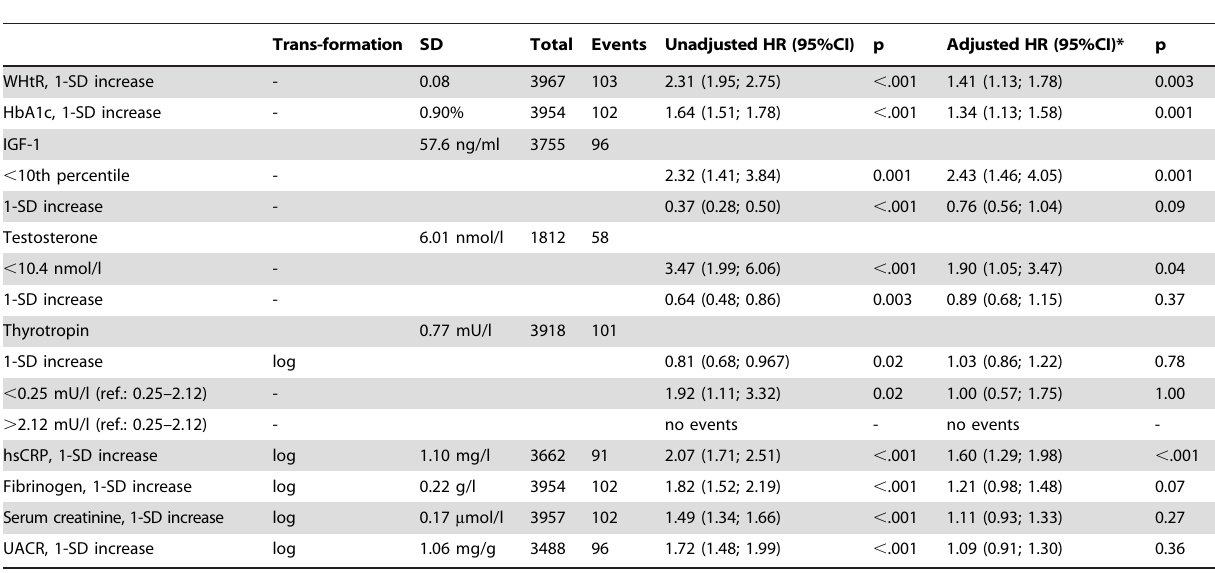
Table 2. Prediction of cardiovascular death by single